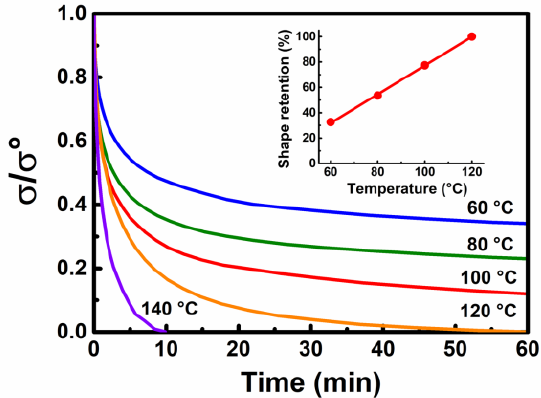
Figure 5. The stress relaxation properties of Ni 2+ -doped films at different temperatures, and inserts show the shape retention.